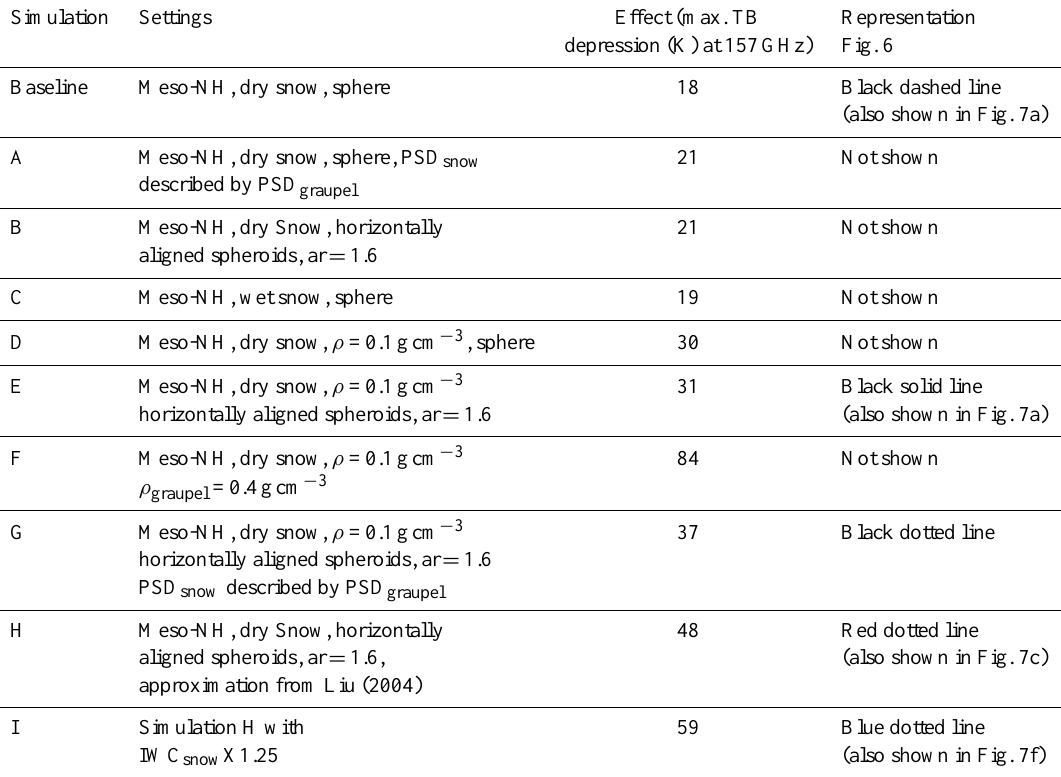
Table 2. A description of the different microphysical assumptions made in the radiative transfer simulations presented. The baseline simu- lation consists of using the Meso-NH microphysical scheme and assuming that snow and graupel species are perfect spheres and that their dielectric properties are defined by the dry snow approach. The effect of the different simulations is here presented as the maximum TB depression at 157GHz along the transect, where the TB depression is defined as TB clear –TB simulation , which should be compared with the max TB depression observed by MHS at 157GHz of 62 K.